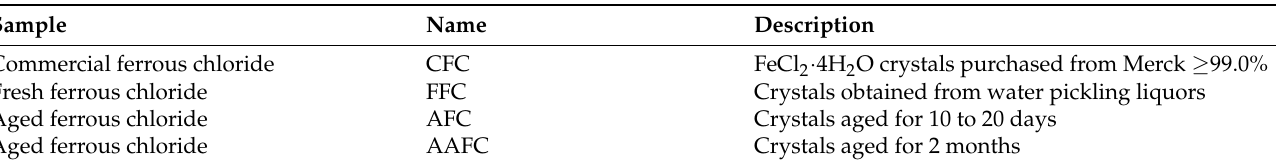
Table 1. Nomenclature and aging description of the samples.